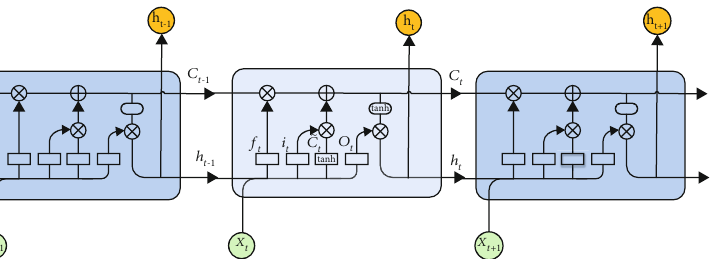
Figure 6: Structure of the LSTM neural unit.